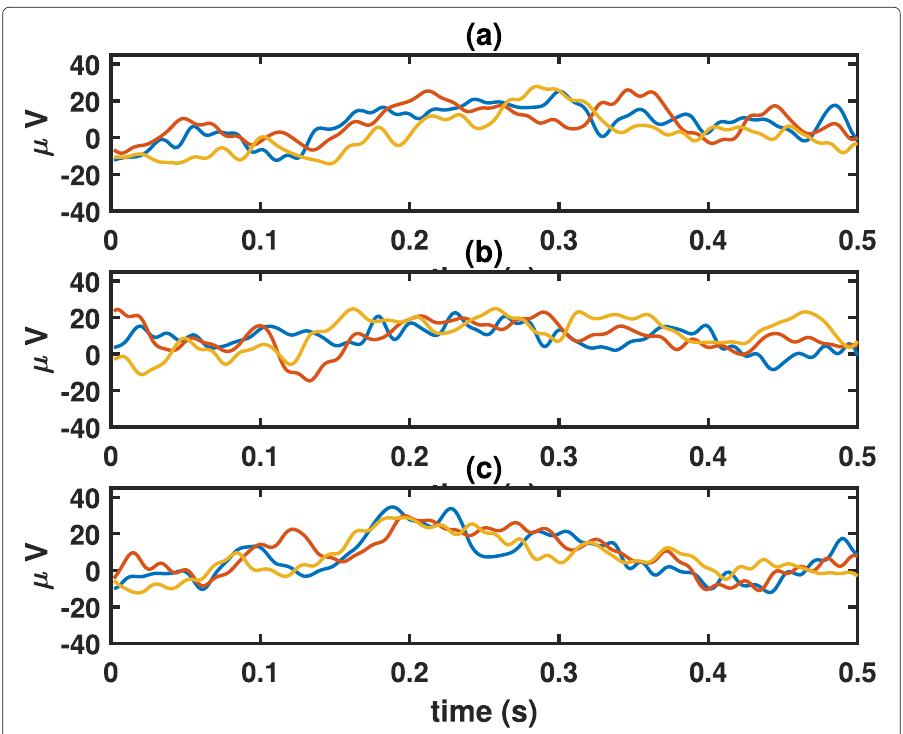
Fig. 9 Three random EEG signals, after 70 Hz low-pass filtering, corresponding to three different trials of a memory task, from each category: a “Faces,” b “Objects,” and c